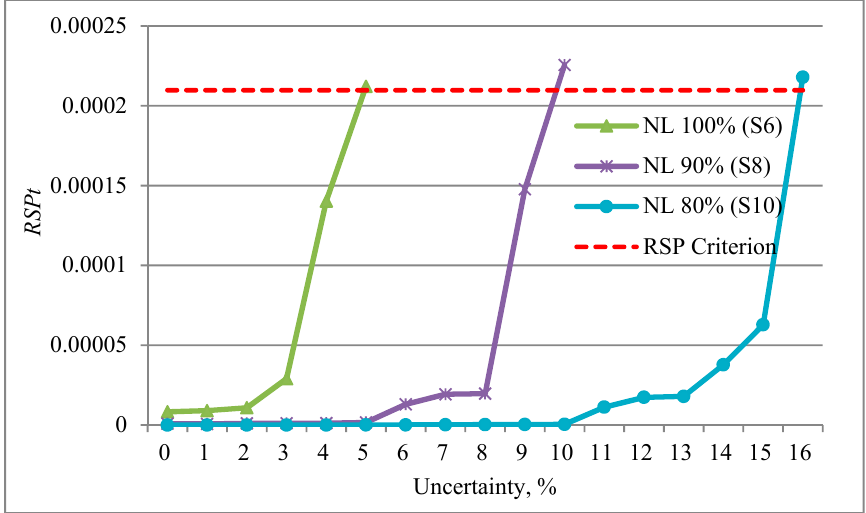
Figure 10. Results of sensitivity analysis for uncertainty: enlarged graph for S6, S8, S10, and RSP criterion.